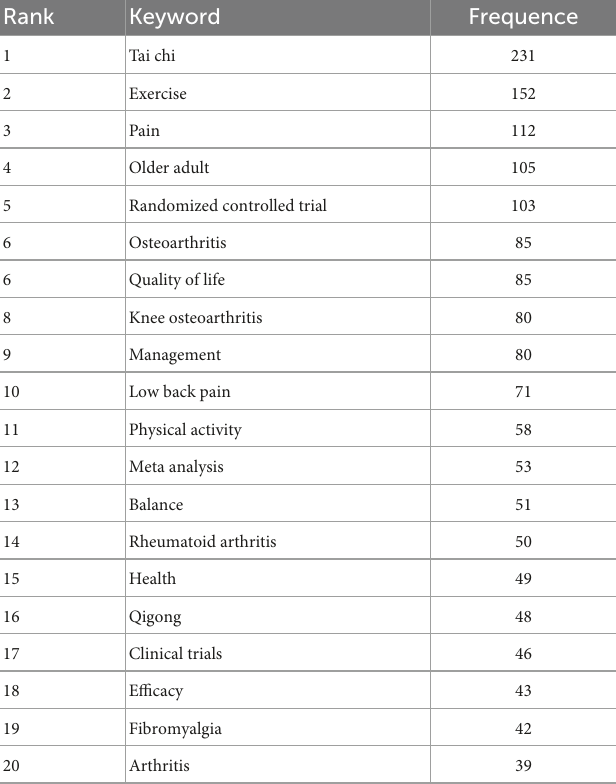
TABLE 8 Top 20 keywords in the treatment of traditional Chinese exercises for musculoskeletal